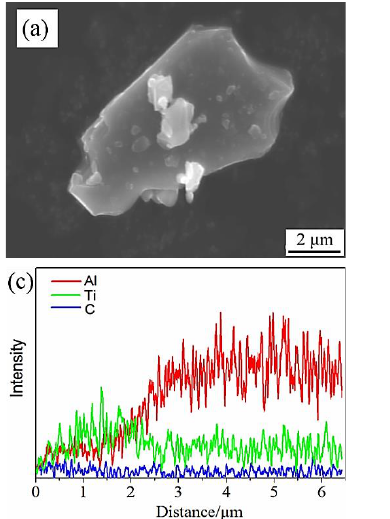
Figure 9. Characterizations of Ti 3 AlC 2 powder coated with Ti: ( a ) microstructure of Ti 3 AlC 2 powder coated with Ti, ( b ) the interface of powder, ( c ) EDS line scanning of the interface.